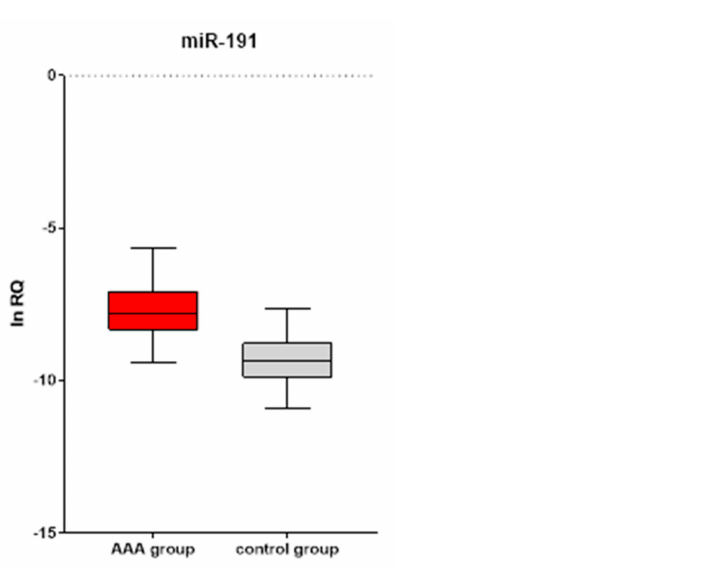
Figure 1. Difference in serum levels of miR-191 between patients and the control group. Values are presented as a natural logarithm of relative